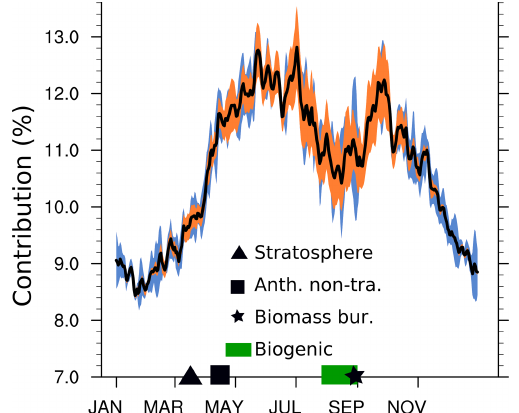
Figure 9. Seasonal cycle of the relative contribution of O tra the ozone column up to 850hPa (in percent). The black line indi- cates the mean contribution as simulated by CM50, averaged over the years 2008–2010 and the two simulations ( REF , EVEU ). The blue shading indicates the standard deviation with respect to time for the years 2008 to 2010 for the EVEU simulation. The orange shading indicates the standard deviation with respect to time be- tween the 2008–2010 averaged seasonal cycles of the REF and the EVEU simulations. The symbols on the horizontal axis indicate the time frames during which the categories named stratosphere, an- thropogenic non-traffic (anth. non-tra.), biomass burning (biomass bur.), and biogenic contribute the